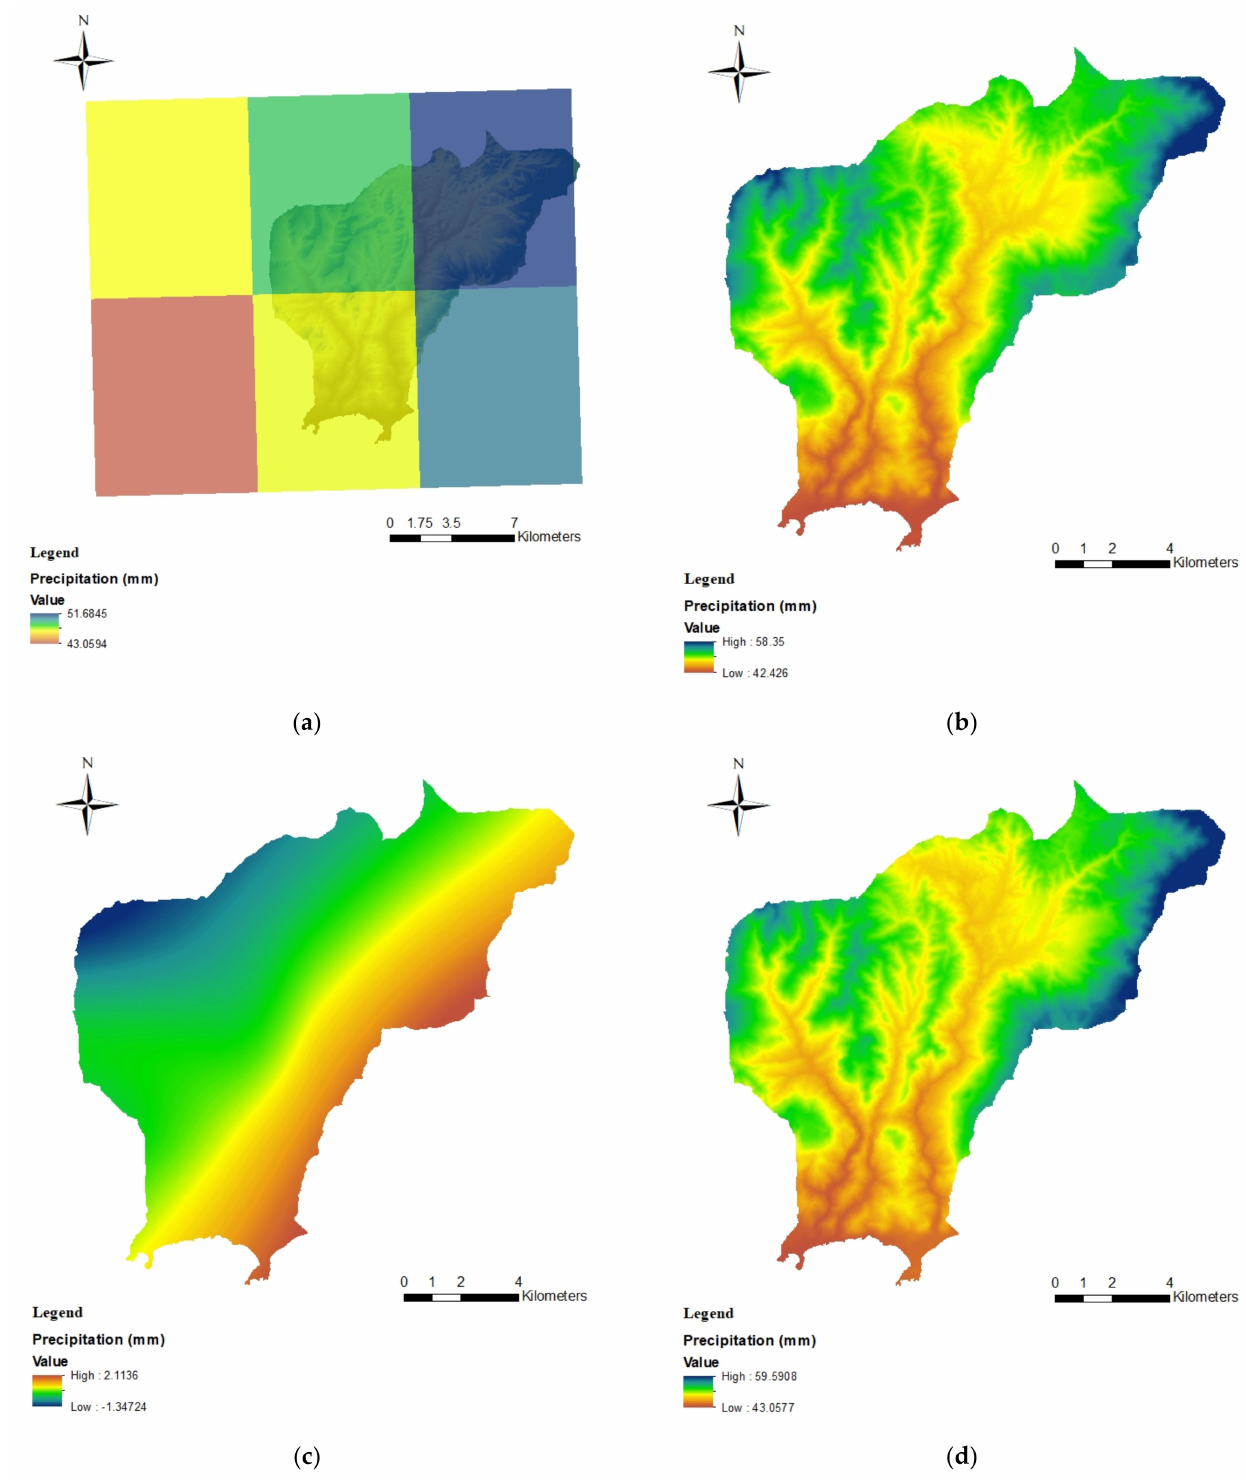
Figure 3. Regression-derived precipitation in the Paleochora region: ( a ) the IMERG precipitation values at 0.1 ◦ resolution; ( b ) the estimated precipitation at 10m resolution; ( c ) the interpolated residuals at 10 m resolution; ( d ) the downscaled precipitation at 10 m